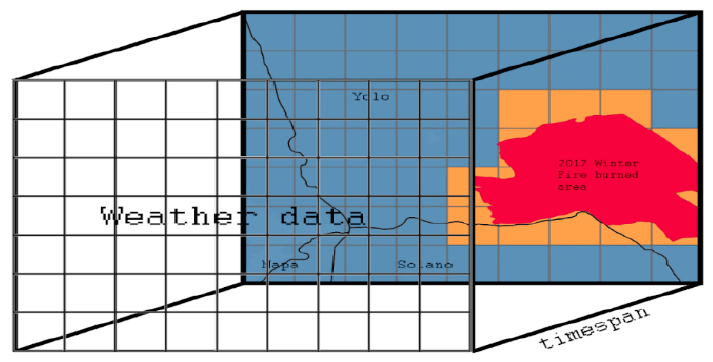
Figure 2. Data mapping design for Base model I.